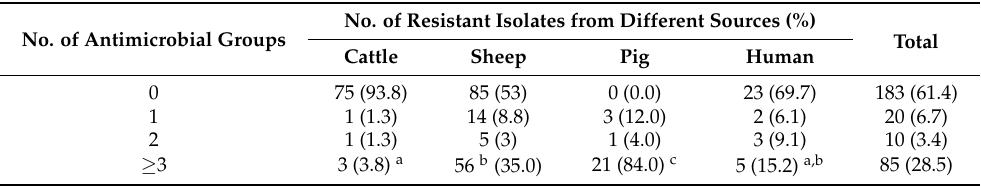
Table 1. The distribution of multidrug resistance (MDR) among the 298 non-O157 STEC isolates. No. of Antimicrobial Groups